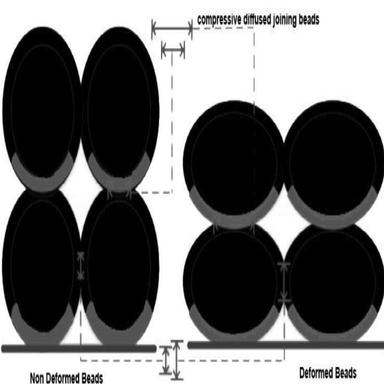
Molecular deformation models during annealing.